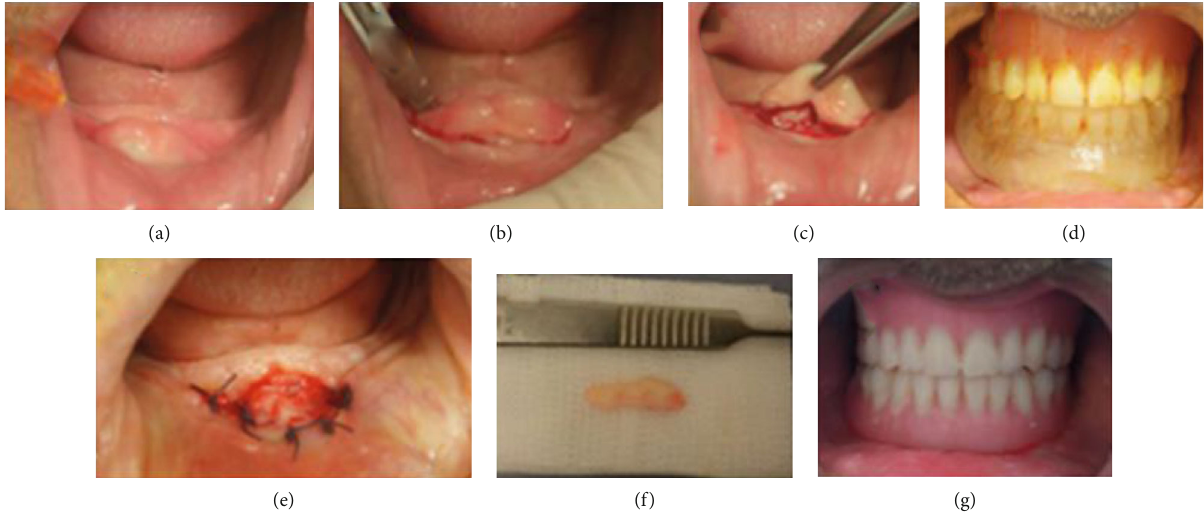
Figure 20: Surgical procedure: (a) in fi ltrative local anesthesia, (b) semilunar incision, (c) total excision using conventional scalpel surgery, (d) surgery control using surgical guide, (e) immediate aspect of the treated area: suture preserving the depth of the buccal side in the mandible. (f ) operatory specimen of the mandibular lesion. and (g) frontal view after immediately prostheses insertion and occlusal adjustment.